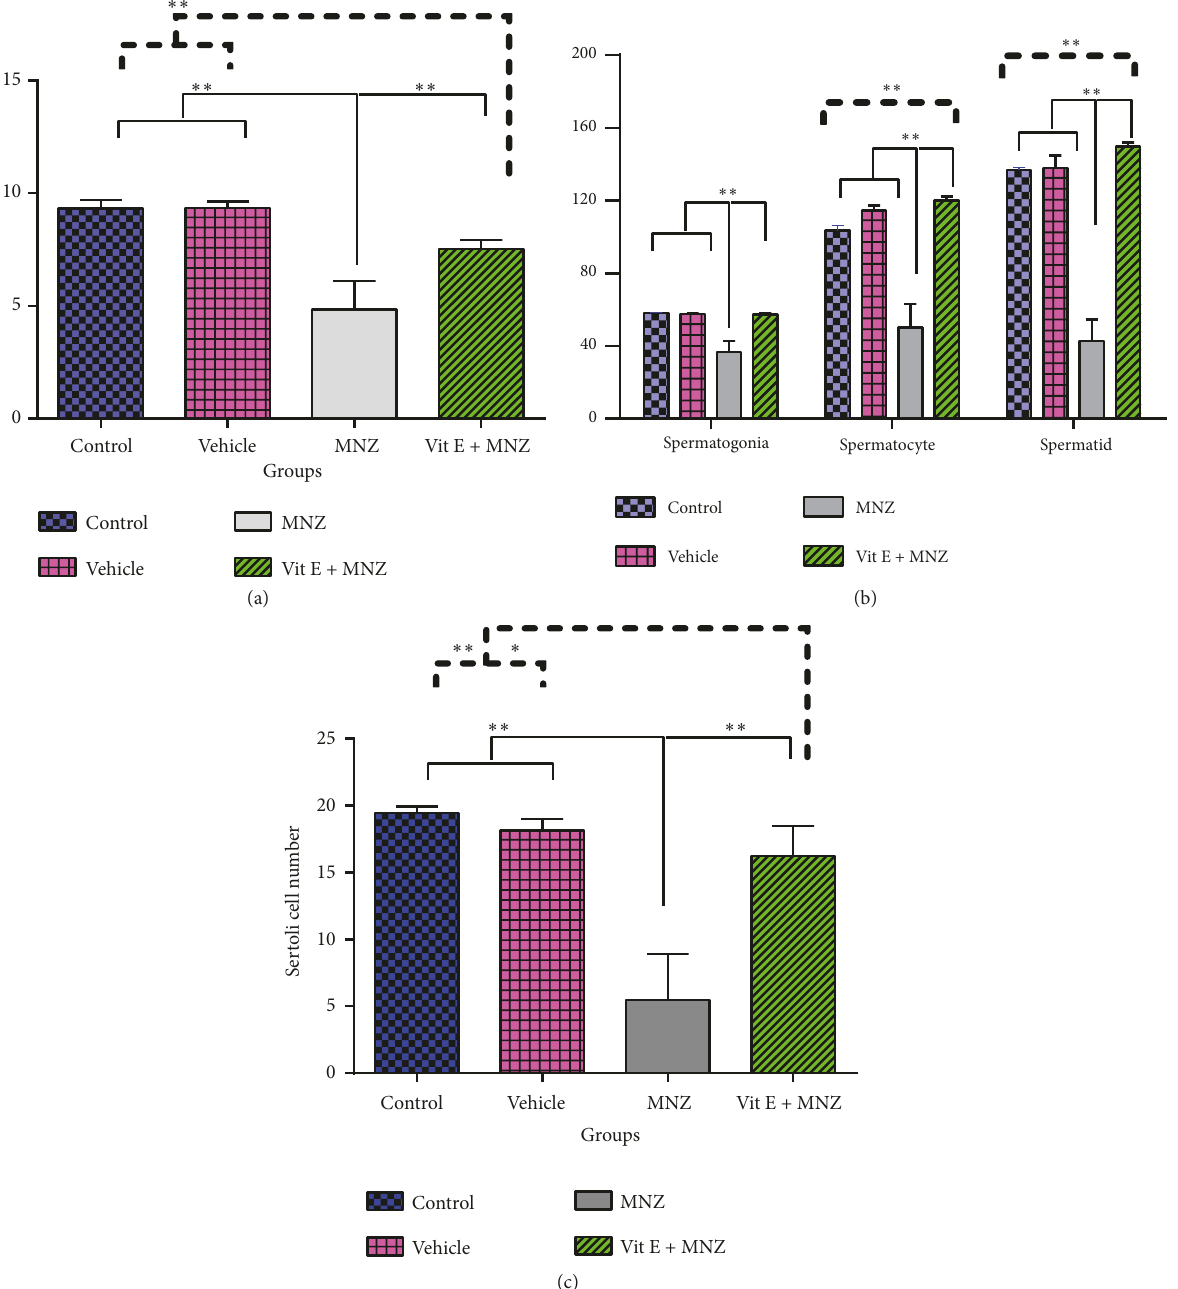
Figure 6: The effect of mancozeb administration alone and with vitamin E during intrauterinelife and lactating periods on the Johnsen score (a) and number of spermatogenesis cell lines (b); spermatogonia, spermatocyte, spermatid, and also the number of Sertoli cells (c) in the different groups (n=7). MNZ: mancozeb. ∗ and ∗∗ indicate p < 0.05 and p < 0.01,